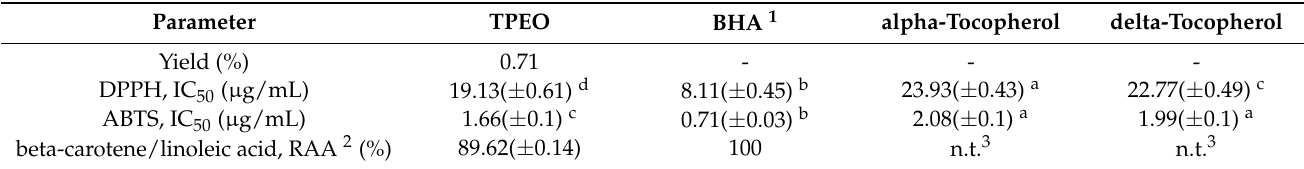
Table 4. Yield, total phenolic content and DPPH radical scavenging activities of the essential oil extracted from T. pulegioides